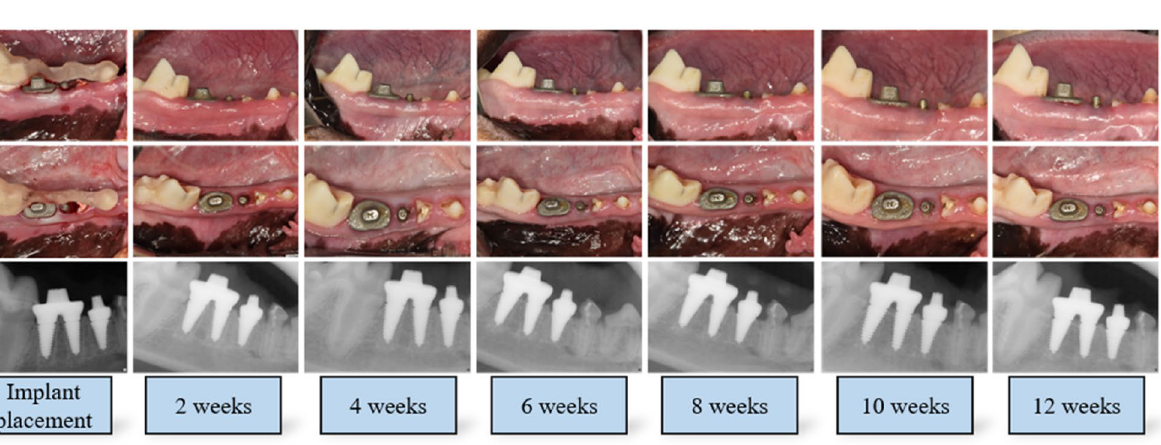
Figure 1. Clinical and radiographic photograph of single- and double-root 3D-printed implant. All protective caps were removed 2 weeks after implant placement for plaque control and implant stability measurements. There were no clinical signs of peri-implant inflammation, including redness, spontaneous bleeding, swelling, or ulceration. The clinical and radiographic photos were taken at the time of implant placement and 2, 4, 6, 8, 10, 12 weeks after implant